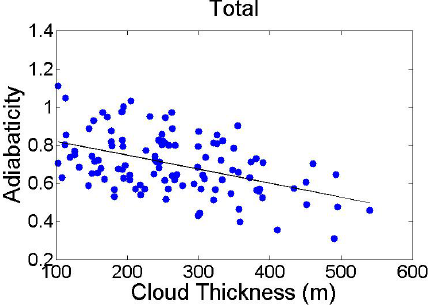
Fig. 4. The adiabaticity of the clouds profiled by the G-1 and C-130 aircrafts as a function of geometric thickness for all cases.